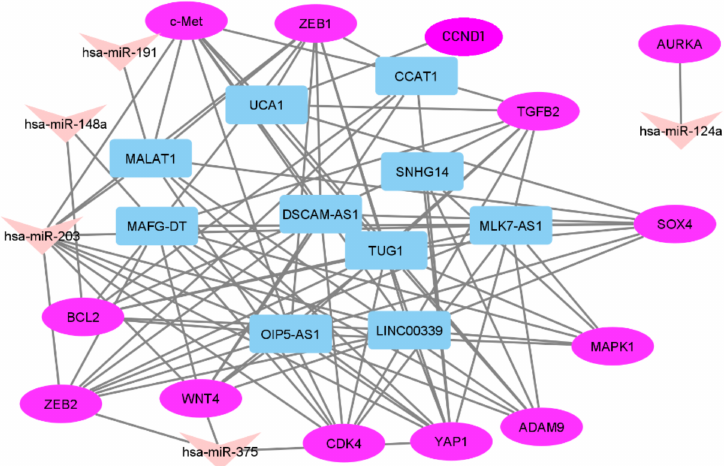
Figure 5. The network between three types of RNAs validated in a set of paired OC samples.